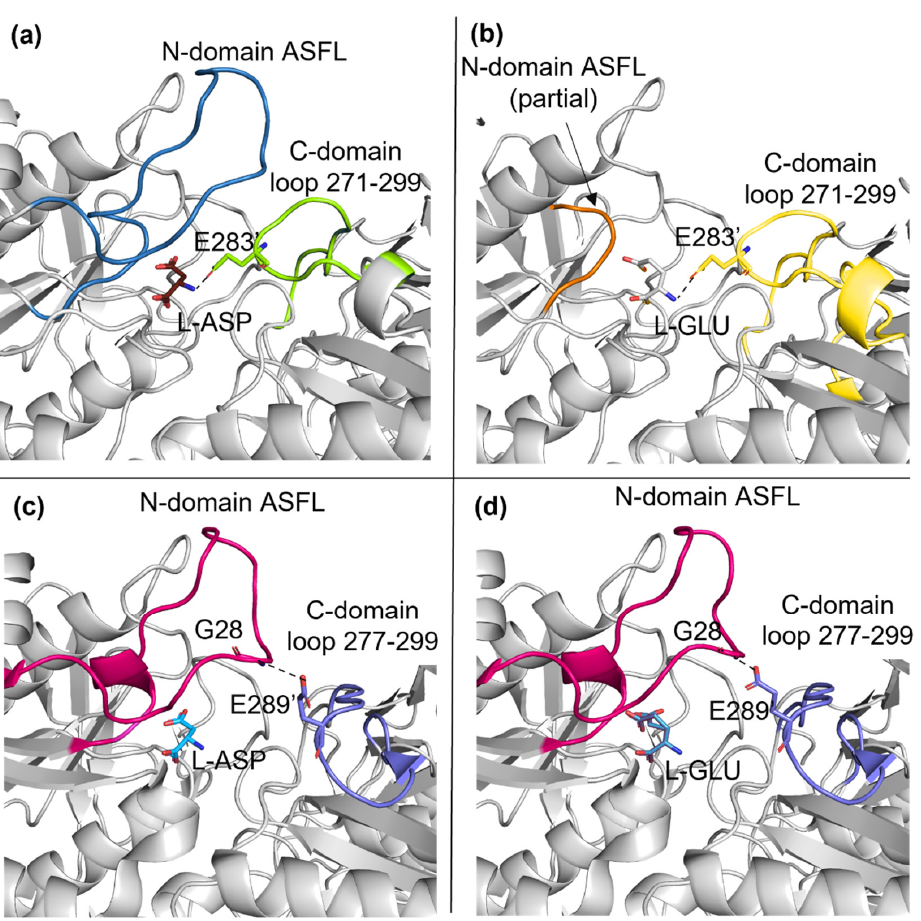
Figure 3. Comparison of EcAII (N24S mutant) and ErAII. ( a ) N24S–ASP (5MQ5) and ( b ) N24S–GLU (7R5Q) active site at the interface of the intimate dimer. ASFL and the C-domain loop are represented as a cartoon and colored in dark blue and light green ( a ), respectively, and in orange and light yellow ( b ), respectively. L–ASP, L–GLU and E283 are represented as sticks. ( c ) ErAII–ASP (5F52) and ( d ) ErAII–GLU (5HW0) active site at the interface of the intimate dimer. ASFL and the C–domain loop are represented as cartoons and colored in magenta and purple, respectively. L–ASP, L–GLU, G28 and E289 are represented as